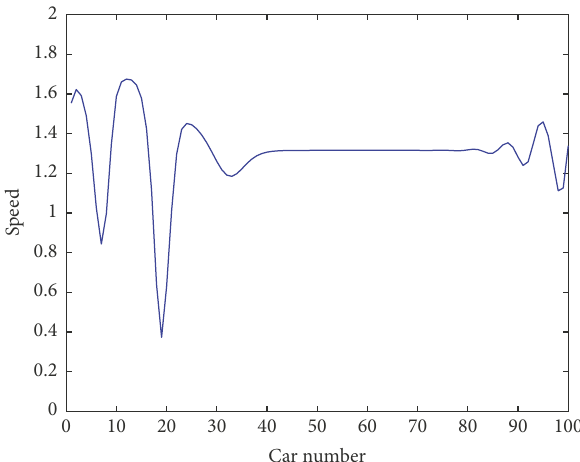
Figure 6: Speed profiles for DSDM with 𝛼 = 0.4 , 𝑇 𝑠 = 1.2 at 𝑡 = 300s.